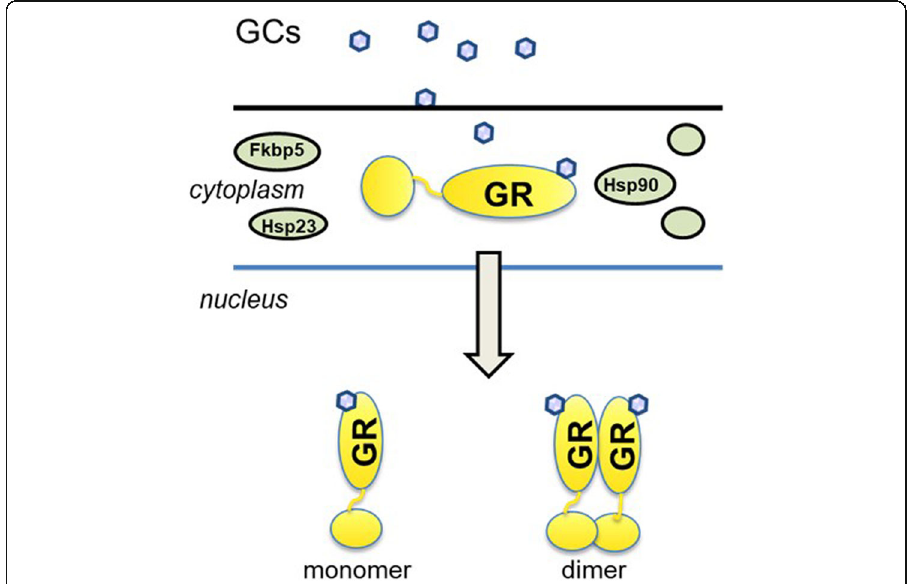
Fig. 2 After binding of the glucocorticoids (GCs are shown as small ellipses) as ligands to the glucocorticoid receptor GR, the immunophillins (Fkbp51, Fkbp52), heat shock proteins (Hsp70, Hsp90, p23), and chaperonic molecules dissociate and the GR translocates in the nucleus. In the nucleus, the ligand- bound GR can either act as a monomer or a